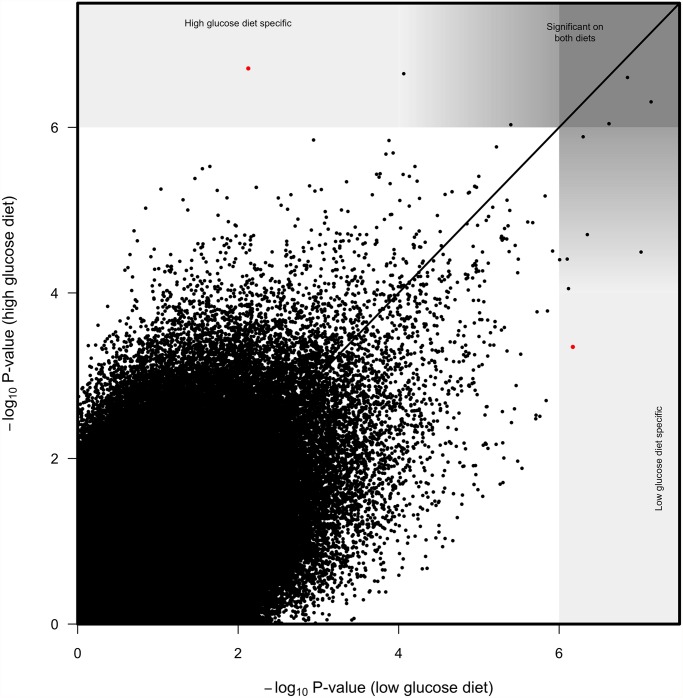
Correlation between SNP log10
p-values from genome wide associations on high glucose diet and low glucose diet.Solid line represents 1 to 1 value. While most significant SNPs were significant on both diets, we considered SNPs with p<10-6 on one diet and p>10-4 on the other diet to be diet specific.